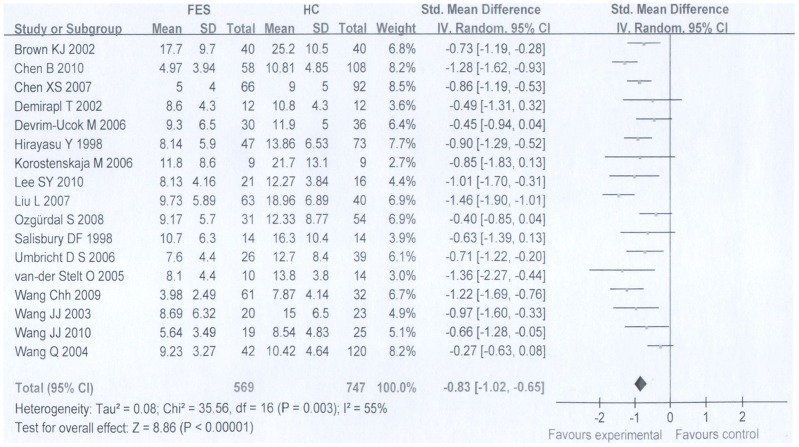
Meta-analysis on the forest map of P300 amplitude of FES group and HC group.